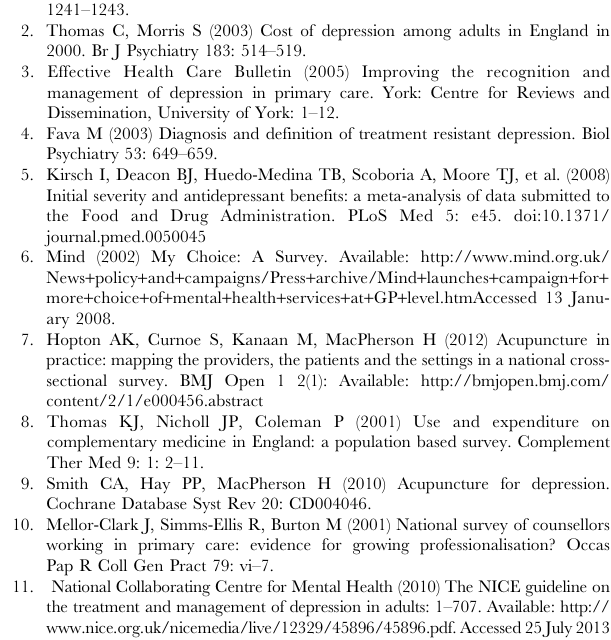
Table S1 Baseline characteristics for patients with and without missing data at 3 months. Table S2 Details of the acupuncture treatment based on STRICTA reporting guidelines. Table S3 Details of the competences that underpinned the delivery of counselling. Table S4 Usual care provided: number of patients seeing a health professional and average number of visits (total and specifically for depression) for these patients in the preceding 3 months. Table S5 Usual care provided: number of patients attending hospital accident and emergency departments and number of attendances in the preceding 3 months.